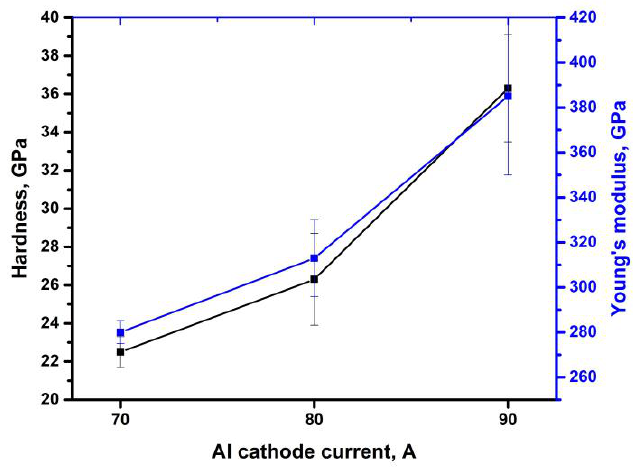
Figure 6. Hardness and Young’s modulus of the deposited coatings.